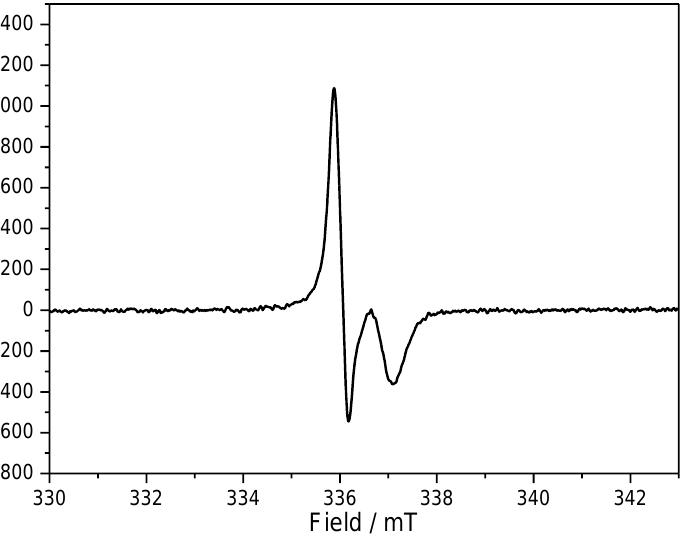
Figure 4. EPR spectrum of the complex of 1 and F 4 TCNQ (0.5 × 10 − 4 mol L − 1 ) in CH 2 Cl 2 at 25 °C. The influence of metal ions on key precursor 2 and Mg-NPc 1 was investigated by absorption titration. As thiacrown ethers are known to coordinate heavy metal ions, the metal-binding studies of 1 focused on the complexation of heavy metal ion Ag + [24,25]. The addition of AgClO 4 to a solution of 2 in CH 2 Cl 2 -MeOH (7:3, v / v ) led to changes in the absorption spectra of the ligands, namely, increased intensity and red-shifting of the absorbances at approximately 230, 321, and 443 nm, and decreased intensity and blue- shifting of the absorbance at approximately 332 nm (Figure 5). The appearance of